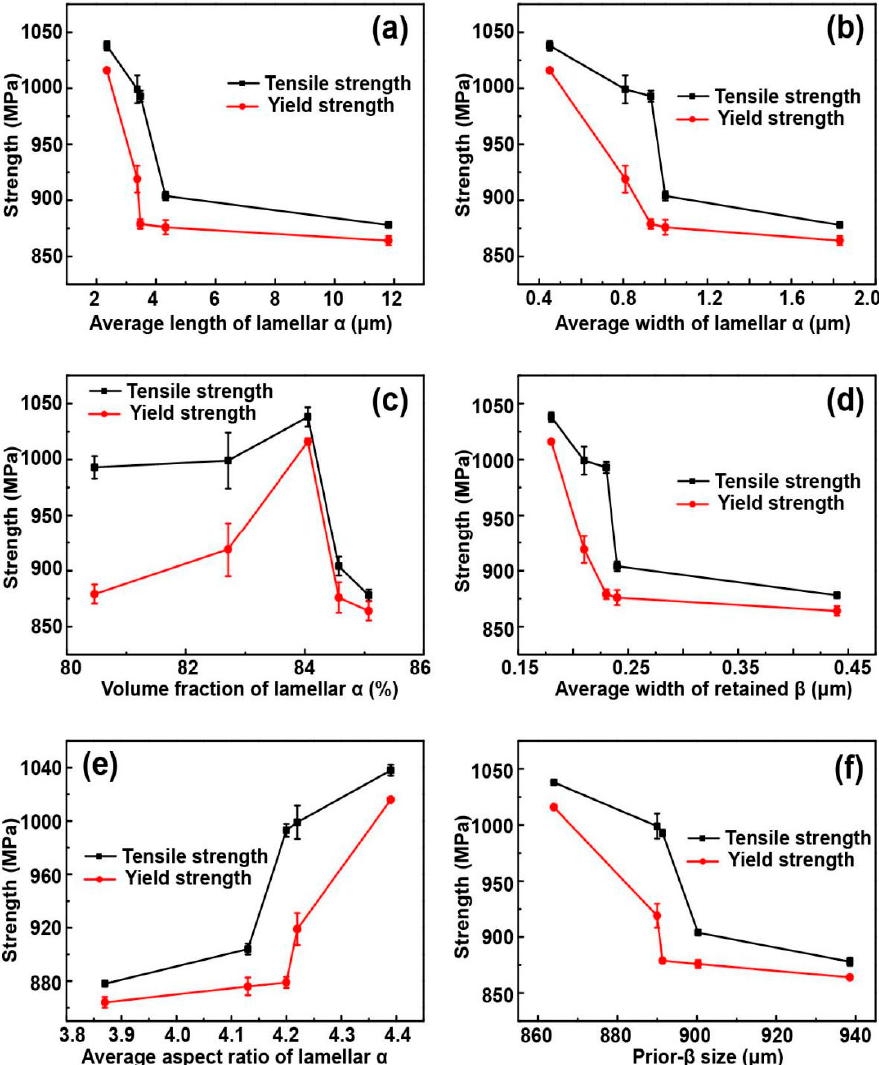
Figure 13. Variations in strength and microstructural features. ( a ) Average length, ( b ) average width, and ( c ) volume fraction of lamellar α ; ( d ) average width of retained β ; ( e ) average aspect ratio of lamellar α ; ( f ) prior- β size.